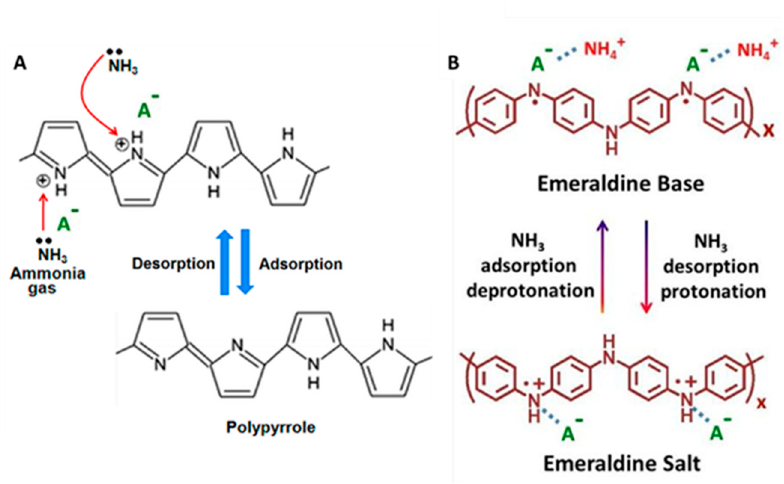
Figure 5. Ammonia sensing mechanism by PPy ( A ) (Adapted from Ref. [104]. Copyright © 2017 SciEP) and PANI ( B ) based gas sensor (Reprinted with permission from Ref. [105] Copyright © 2020